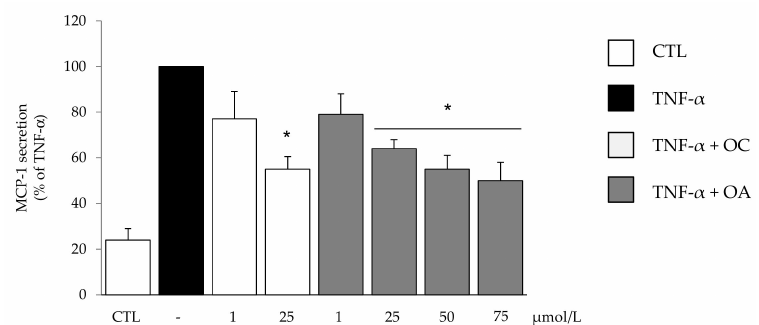
Figure 2. The e ff ect of OC and OA on monocyte chemoattractant protein (MCP-1) protein release in the culture medium. SGBS cells were pretreated (6 h) with either OC (1–25 µ mol / L) or OA (1–75 µ mol / L) before 10 ng / mL TNF α stimulation for 18 h. MCP-1 in the culture medium was determined by ELISA, and expressed as percent of TNF- α stimulation. Data are means ± SD (n = 3). * p < 0.05 versus TNF- α